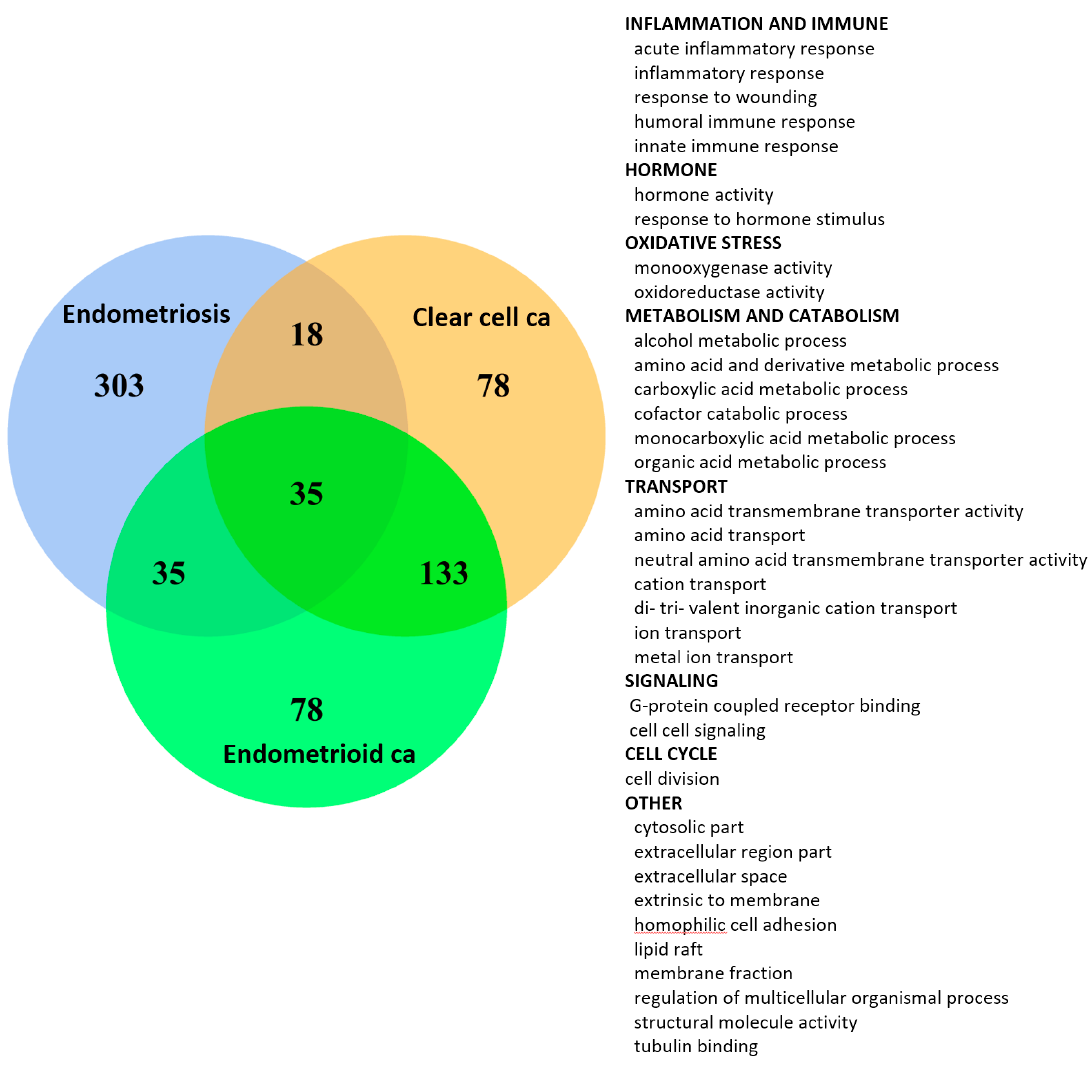
Figure 7. Venn diagram of the deregulated GO term elements from exploratory factor analysis for the three diseases. The figure shows the results of the three diseases with the total factor elements for each disease. Their relationship is displayed on the Venn diagram to show the gene set numbers of all possible logical relations among the three diseases. The 35 commonly-deregulated GO terms among ES, CCC and EC are listed on the right side of the figure.